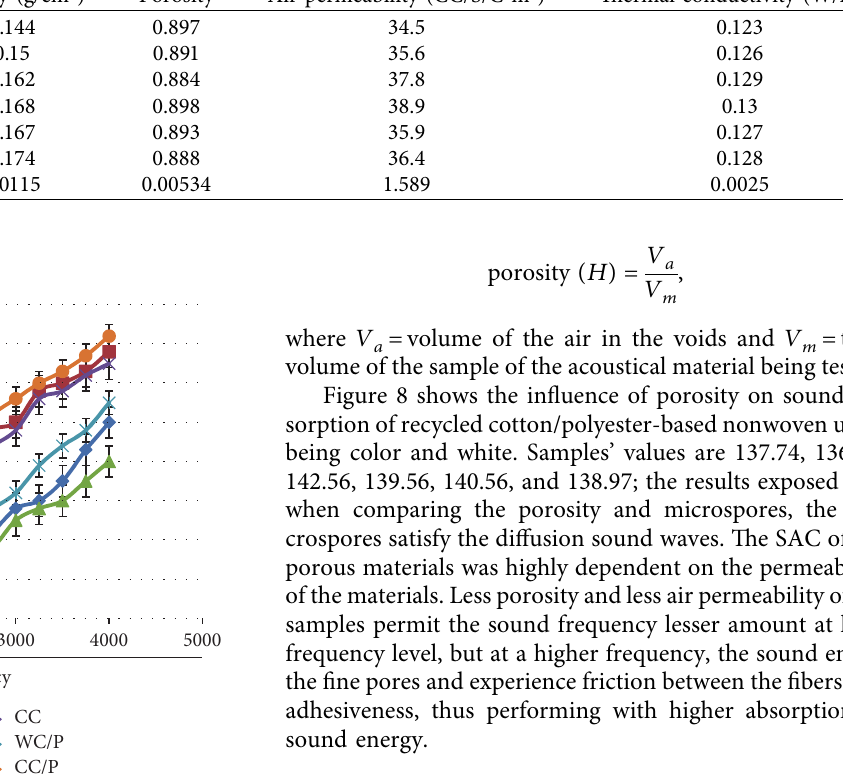
Figure 5: Variation of sound absorption coefficient with